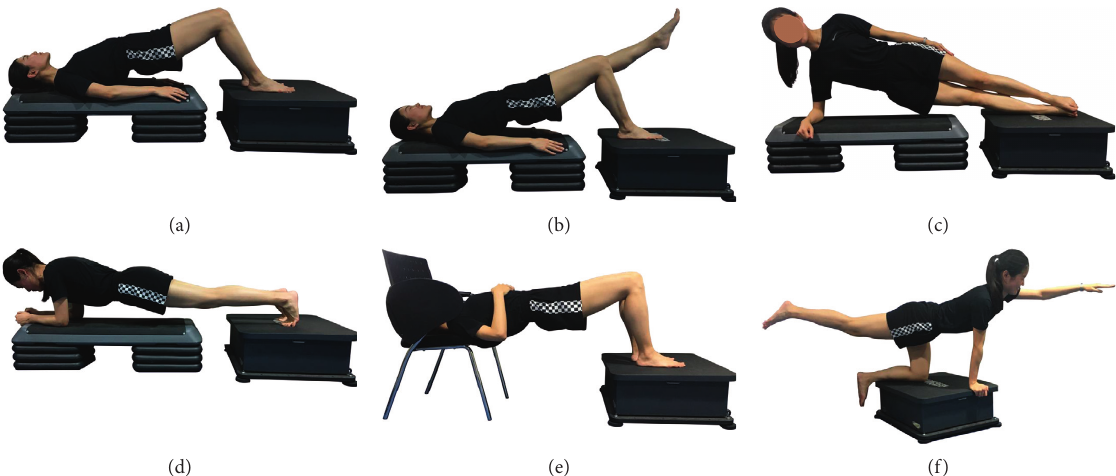
Figure 2: Training program for whole-body vibration exercise. Training program included (a) bridge, (b) bridge with leg lift, (c) side plank, (d) plank, (e) inverse bridge, and (f) balancing table